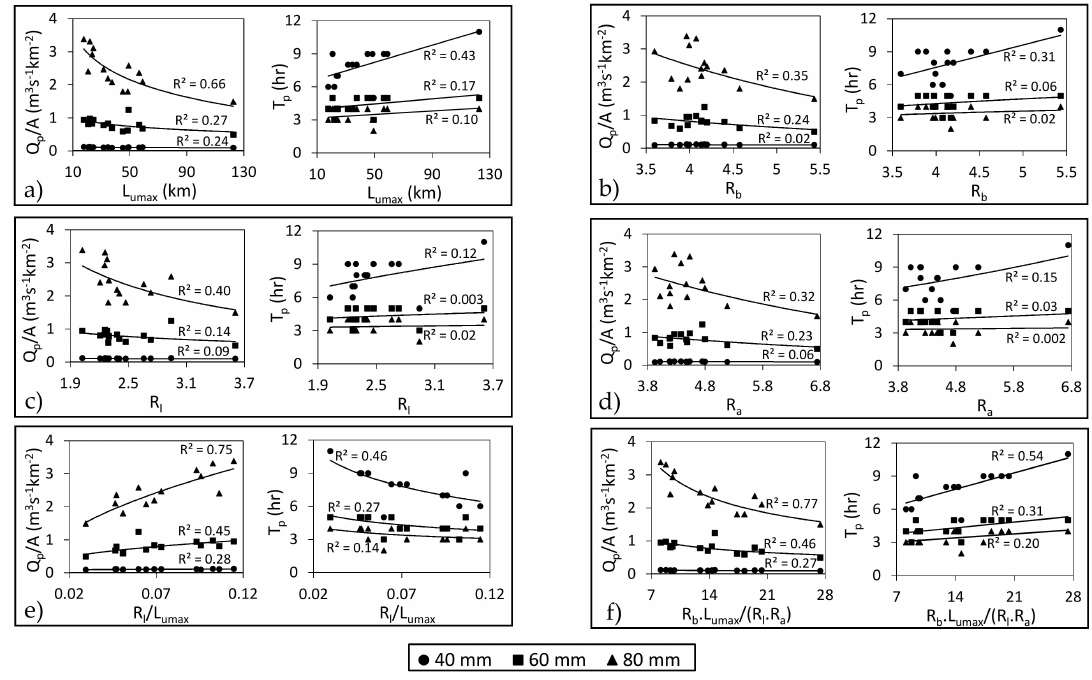
Figure 15. Correlation between the hydrological indices and drainage network measures based on stream order: ( a ) maximum order stream length ( L umax ), ( b ) bifurcation ratio ( R b ), ( c ) length ratio ( R l ), ( d ) area ratio ( R a ), ( e ) R l /L umax and ( f ) R b .L umax /(R l .R a ) under different storm